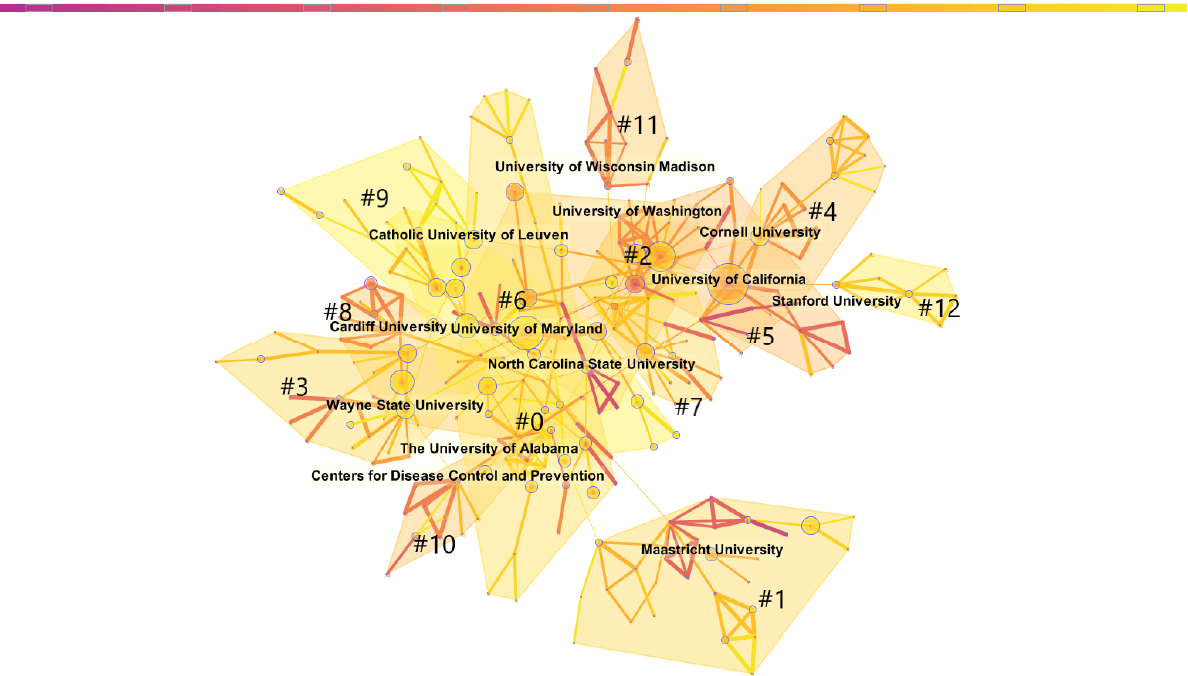
Figure 5. Institution co-authorship network of crisis and risk communication research.